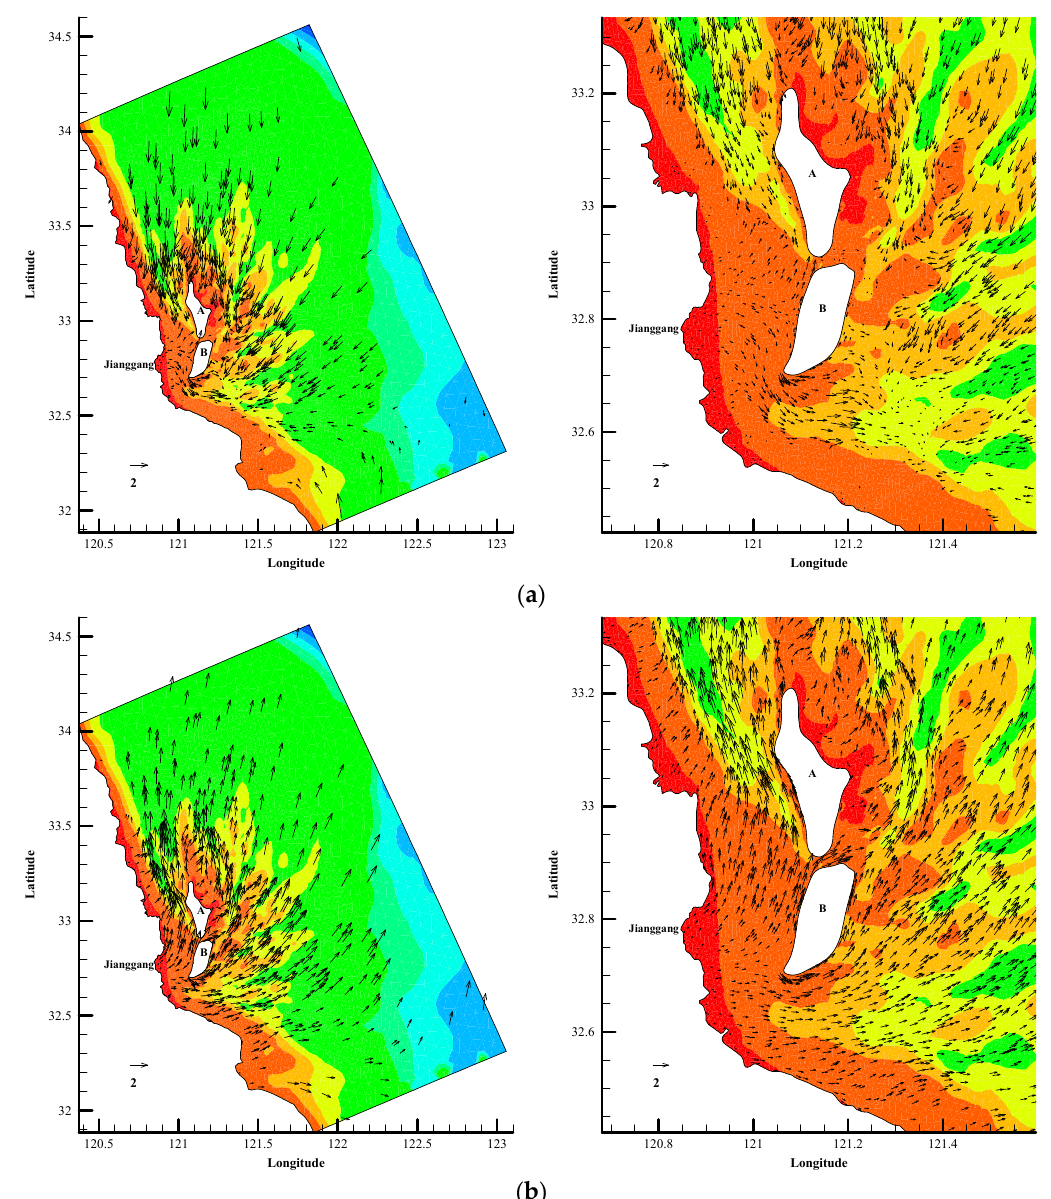
Figure 9. Maximum flood and ebb current fields when the RSRs are partially reclaimed (the base map shows the topography: left is the global tidal current field and right is the local tidal current field); ( a ) Maximum flood; ( b ) Maximum ebb.